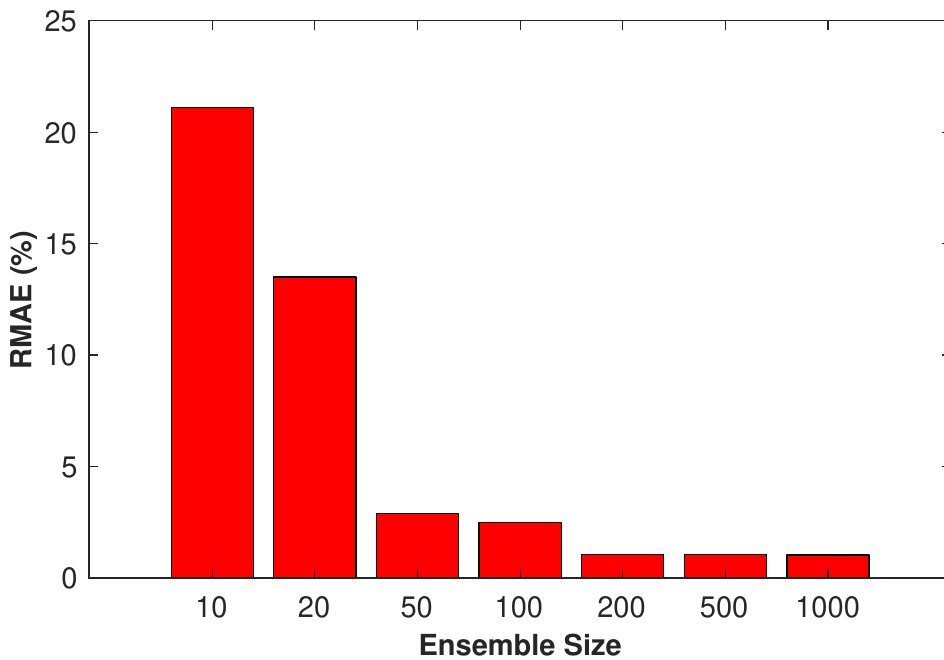
Figure 2. RMAE of the number of deaths as a function of ensemble